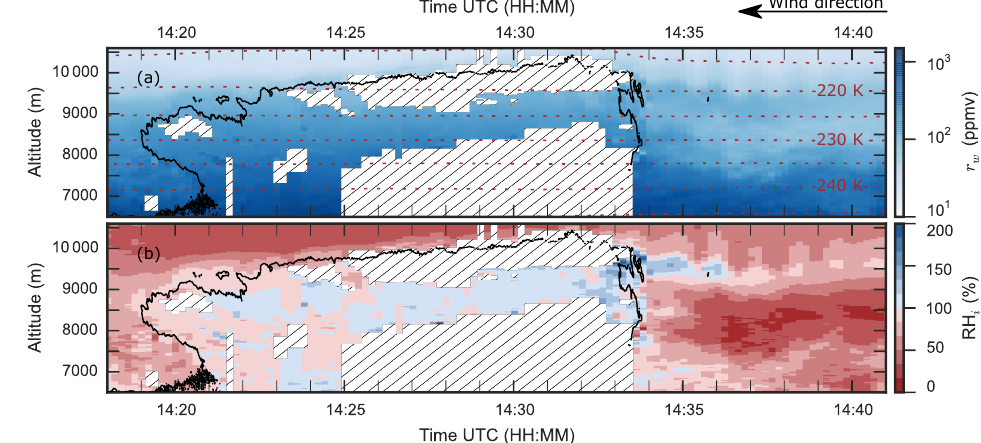
Figure 4. Humidity data of cirrus marked in Fig. 3: (a) water vapor mixing ratio r w as measured with WALES and ECMWF temperature contour lines. (b) Relative humidity with respect to ice RH i derived from WALES data and ECMWF temperature field. The cirrus is outlined by a black contour line (BSR = 2) and invalid data are marked by black hatching.